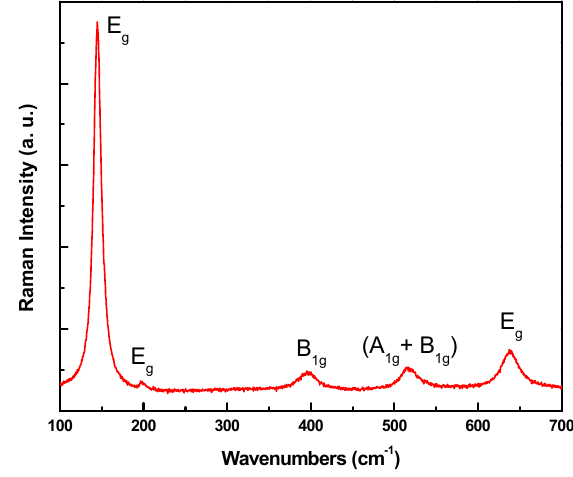
Figure 4. Raman spectrum of annealed TiO 2 nanotube arrays.